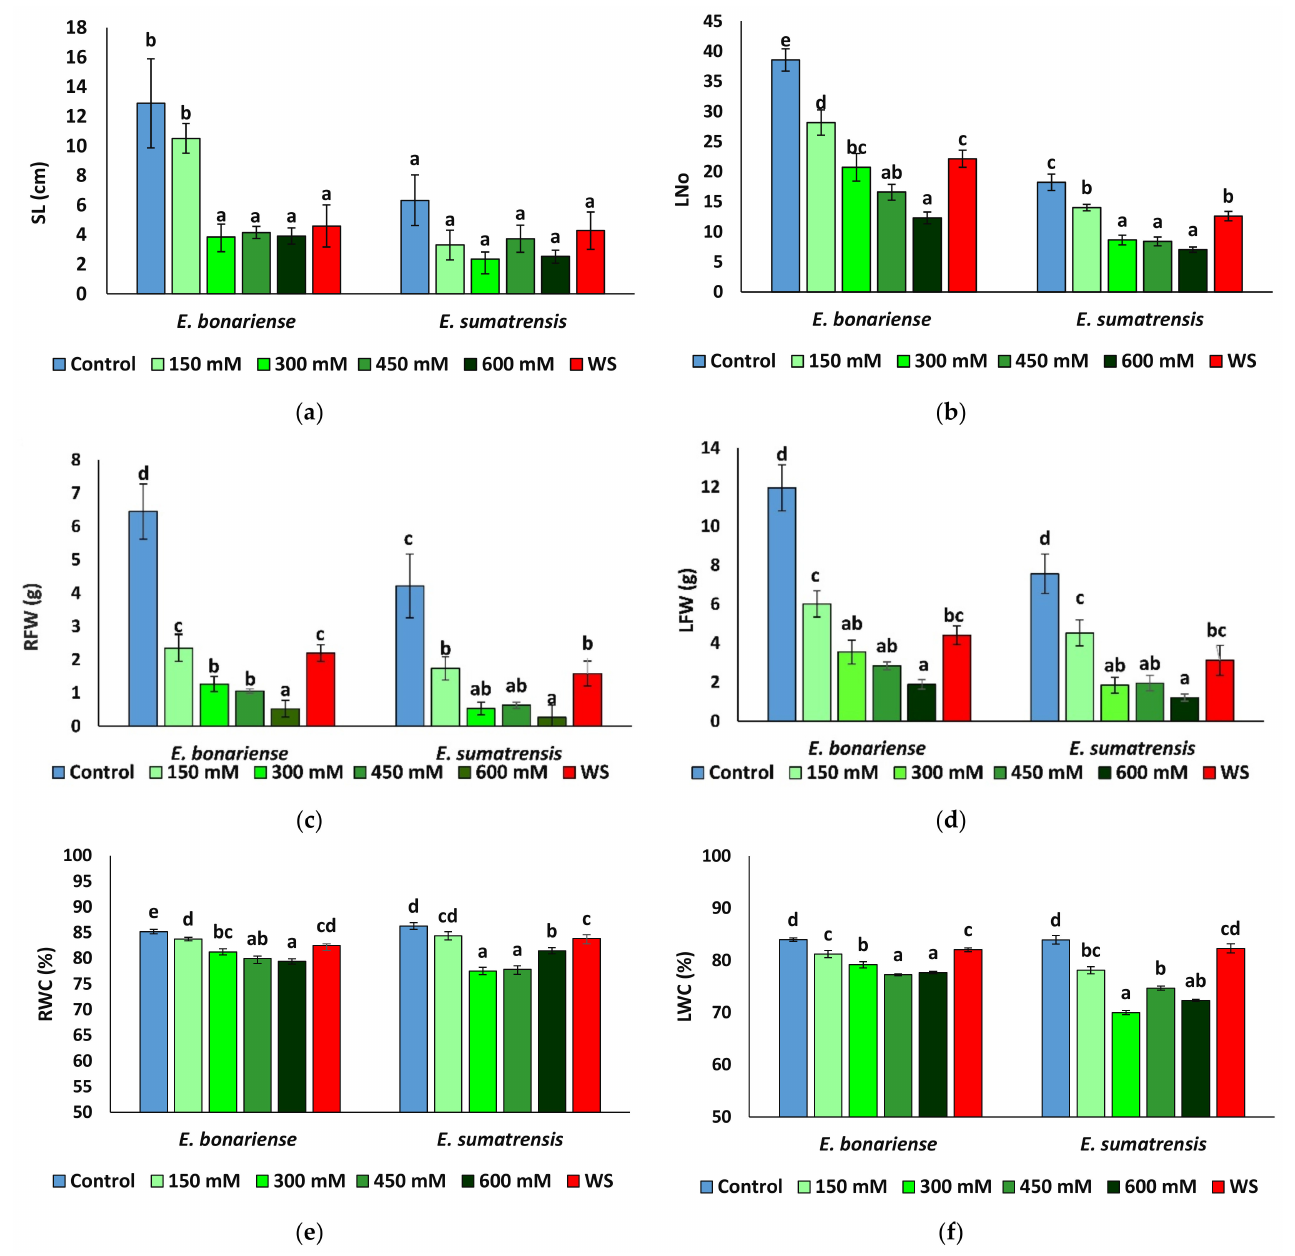
Figure 4. Growth parameters in the two Erigeron species after 1 month of water stress (WS) and treatments with NaCl at the indicated concentrations: ( a ) stem length (SL); ( b ) number of leaves (Lno); ( c ) root fresh weight (RFW); ( d ) leaf fresh weight (LFW); ( e ) root water content (RWC), ( f ) leaf water content (LWC). Means ± SE, n = 7. Same letters indicate homogeneous groups between treatments for each species, according to the Tukey test ( α =